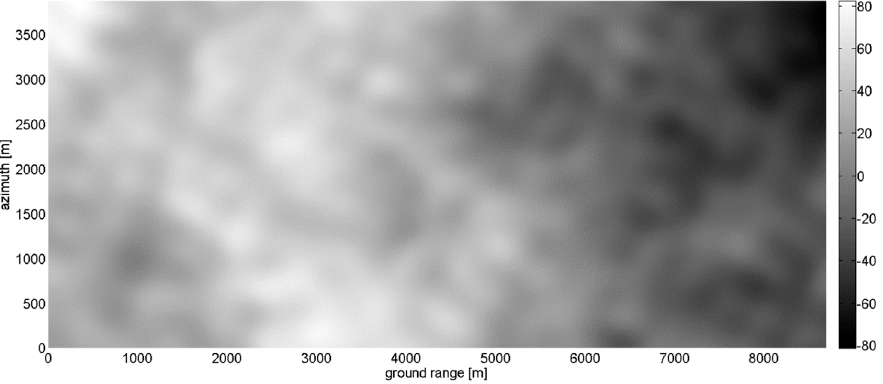
Figure 11. Simulated fractal DEM with H = 0.5 and T = 10 − 5 m in azimuth-ground range. Color bar is in meters.